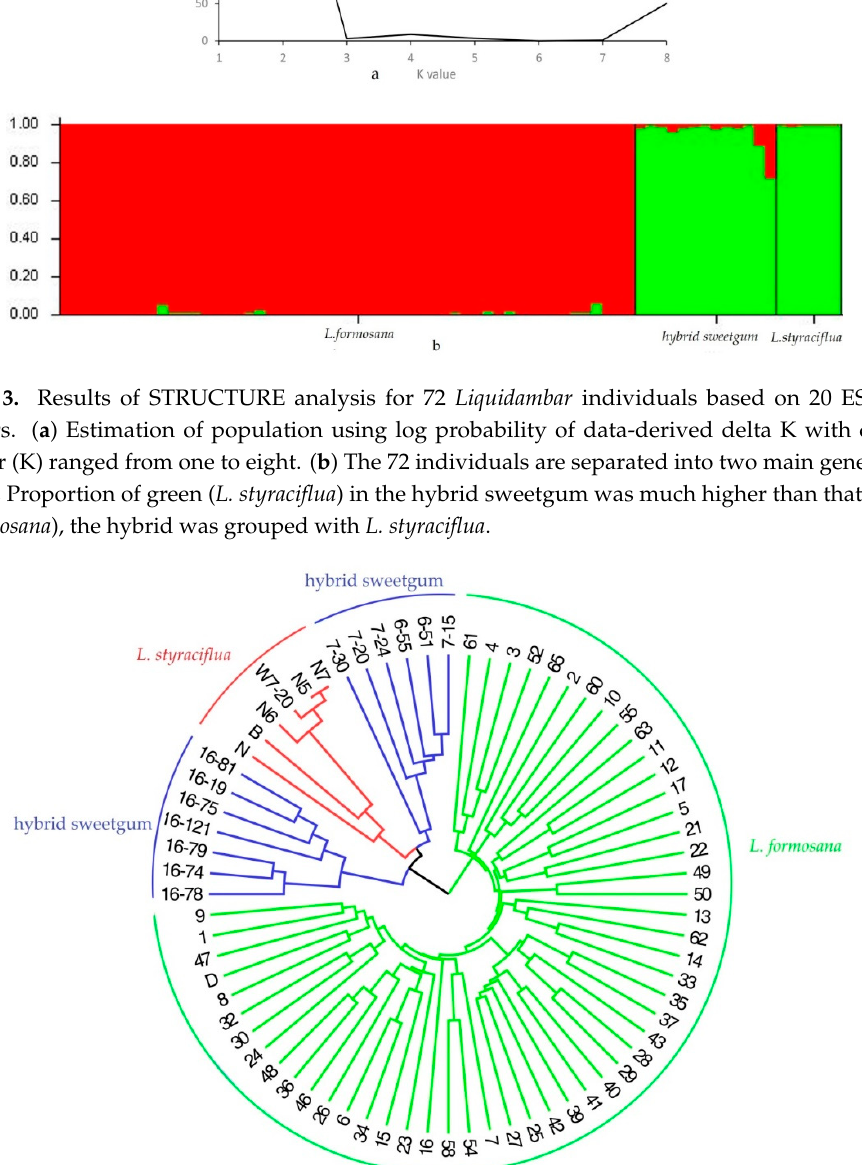
Figure 5. Principal coordinate analysis (PCoA) of 72 individuals of three species Liquidambar based on 20 EST-SSR markers. The blue squares represent L. formosana, the green filled circles represent hybrid sweetgum and the red triangles represent L. styraciflua. The first two coordinates explain percentages of total variation for 41.22% and 15.63%, respectively. 4. Discussion L. formosana is highly adaptable, grows rapidly in forests, exhibits a straight trunk and wide crown, and is economically, ecologically, and medically valuable; thus, it is a genuine “multi-purpose tree” [1,2]. However, molecular genetic data are lacking for L. formosana because the molecular tools required are not available. SSRs are efficient genetic markers widely used for MAS, distinguishing among tree varieties, constructing genetic atlases, and researching genetic diversity [21]. The development of SSR markers based on transcriptome sequencing is one of the currently recognized